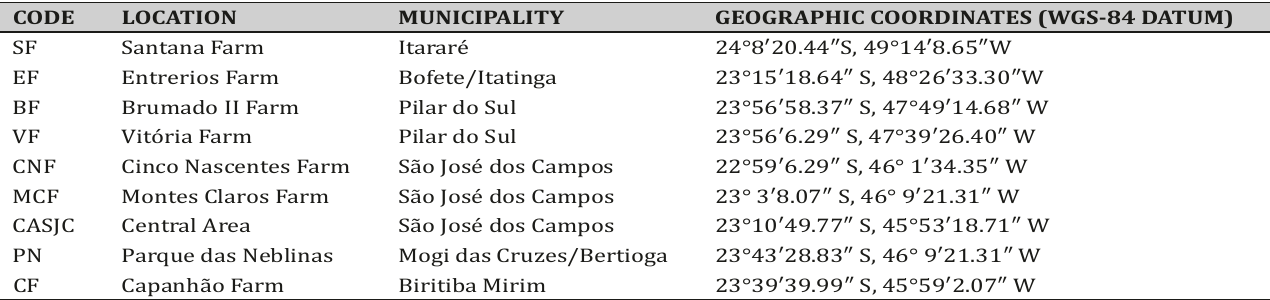
Locaties sampled in the state of São Paulo from October 25th to November 25th 2010 and from April 28th to May 28th